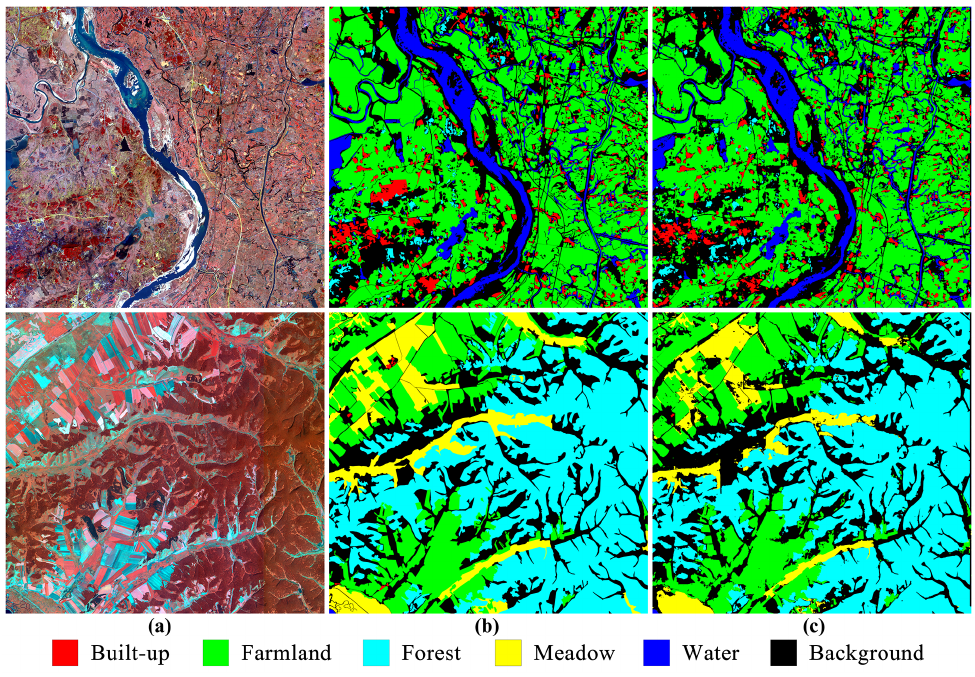
Figure 7. The segmentation result of XANet on the LSC dataset: ( a ) Image; ( b ) Ground truth; and ( c ) Segmentation result.